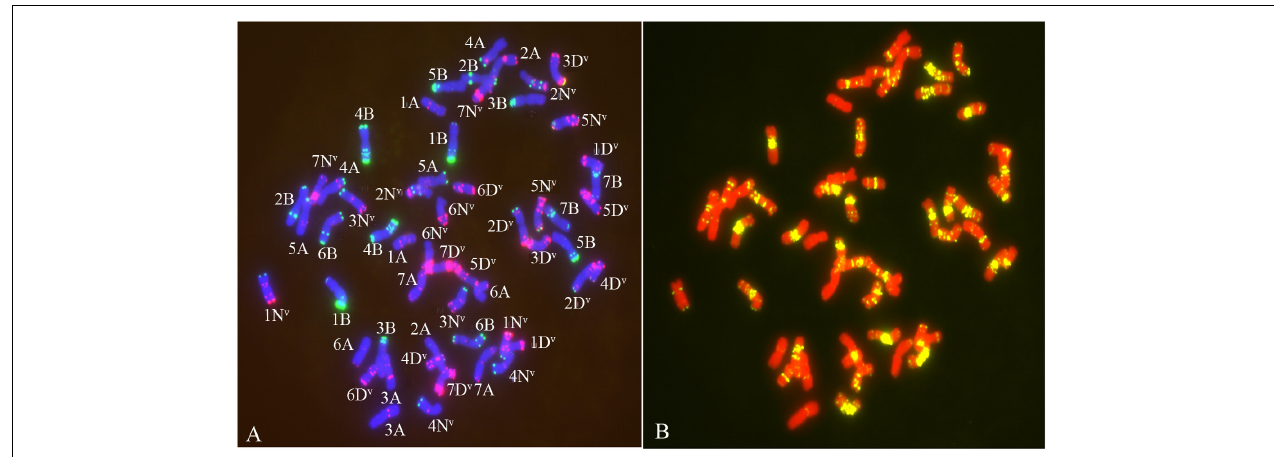
FIGURE 4 | The FISH pattern from euploids. (A) Chromosomes staining with DAPI (blue) oligo-nucleotides Oligo-pSc119.2 (green), Oligo-pTa535 (red). (B) chromosomes staining by DAPI (red) and Oligo-(GAA) 7 (yellow).